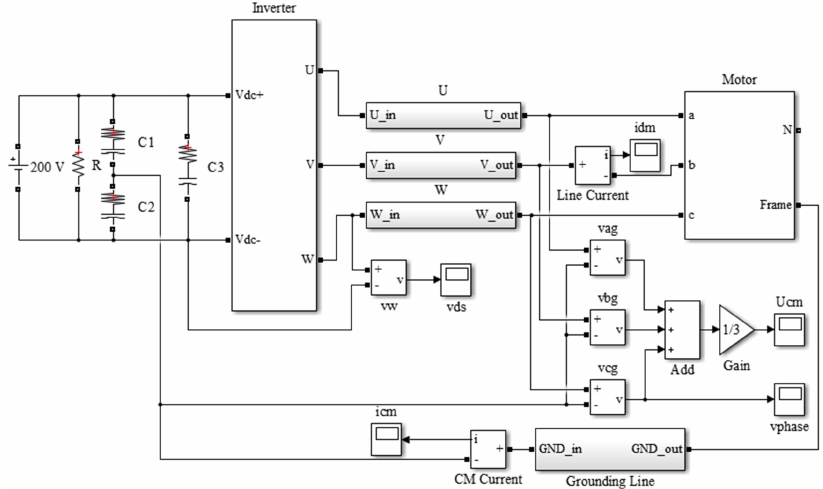
Figure 10. Simulation model of the motor